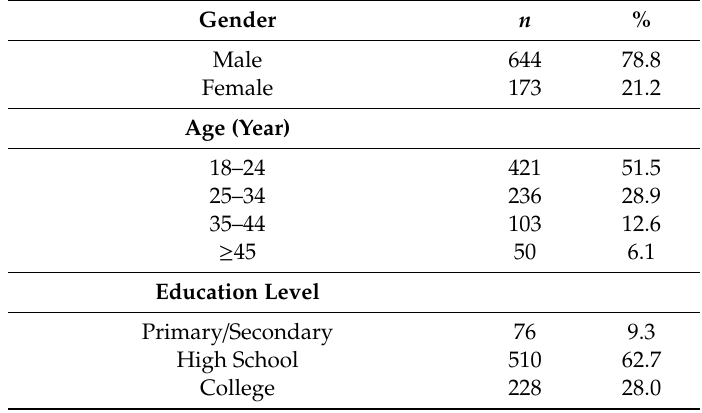
Table 1. Sociodemographic Characteristics of